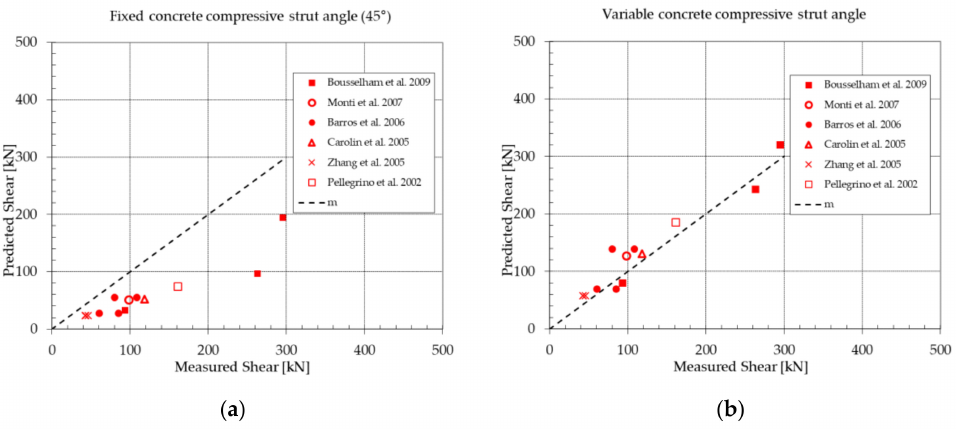
Figure 10. Beam before retrofitting: experimental and predicted shear strength values considering ( a ) the fixed or ( b ) the variable inclination angle of the concrete compressive strut. The statistical values of the ratio V Rd,exp /V Rd for each beam in Figure 10a,b, are given in Table 5. Table 5. Statistical values of the predictions: mean, Standard deviation, Coefficient of Variation, max, min, 5% and 95% percentile of the ratio V Rd , exp /V Rd . St. 5% 95% Mean CoV max min Deviation Percentile Percentile Fixed V Rd,exp /V Rd angle